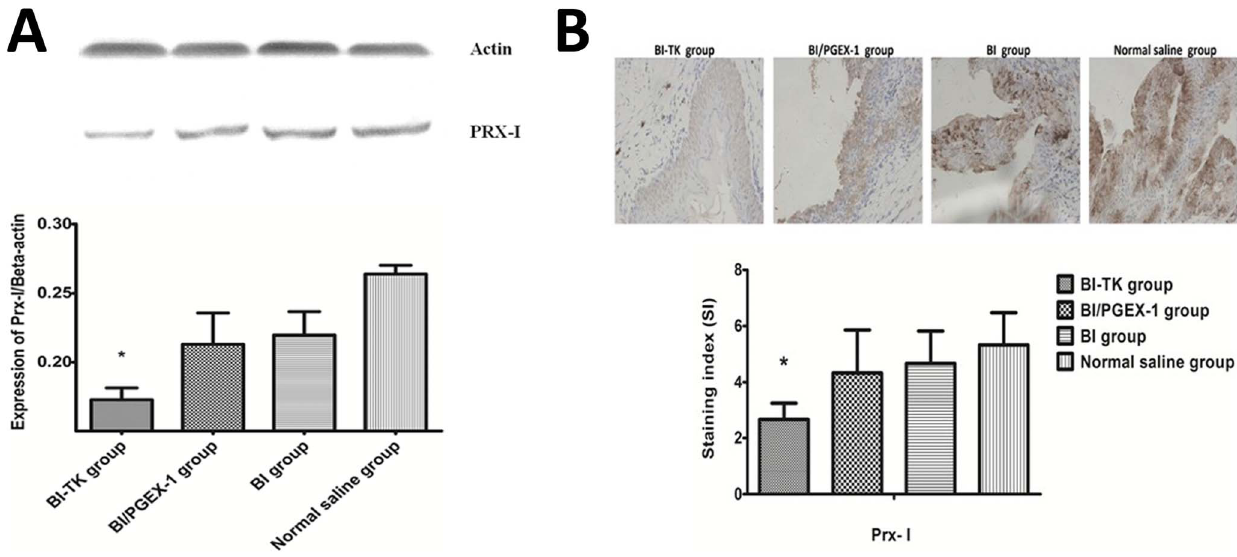
Figure 3. Validation of Prx-I by Western blot and immunohistochemical (IHC) analysis. A: Expressions of Prx-I in four groups by Western blot analysis. Beta-actin was used as a loading control. B: Representative images showing the immunoexpression of Prx-I in tumor tissues of four groups. Compared with the normal saline group, expression of Prx-I is down-regulated in the other three groups (especially in the BI-TK group), which is similar to the results obtained by iTRAQ. (Asterisk (*) indicates P , 0.05 in BI-TK group versus normal saline group)